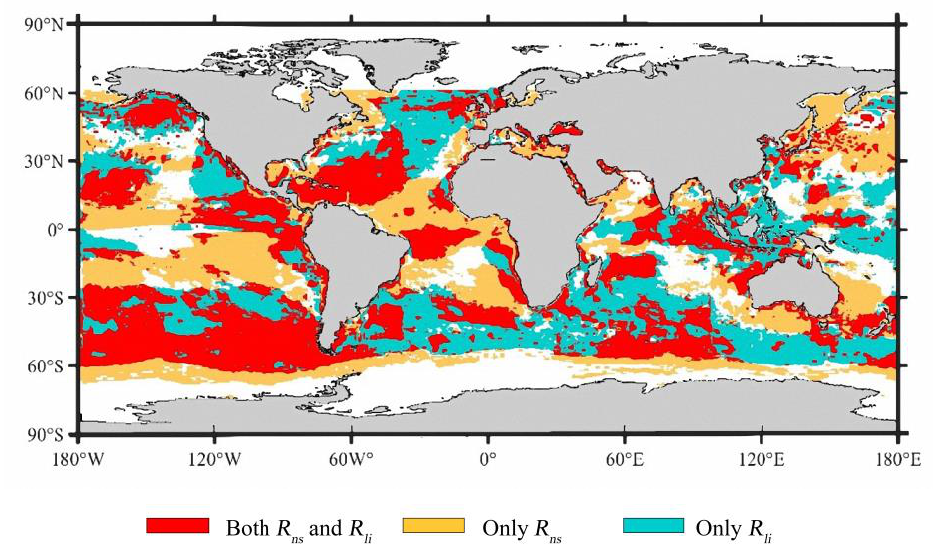
Figure 9. The determined pixels in the J-OFURO3 that needed to be corrected.